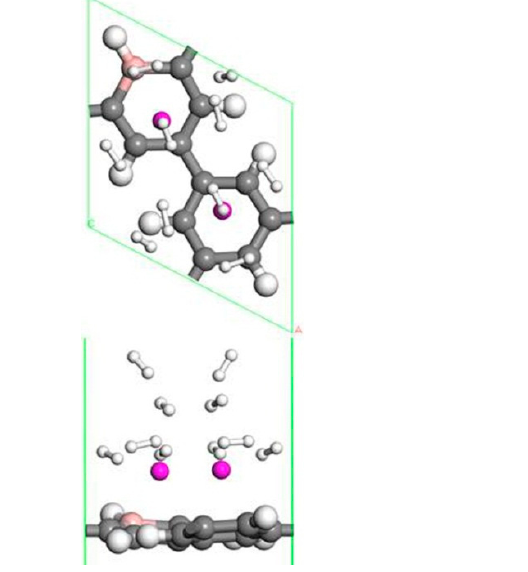
Figure 8. The optimized geometries for ten H 2 molecules adsorbed on two Sc atoms single-sided modified B-PG.